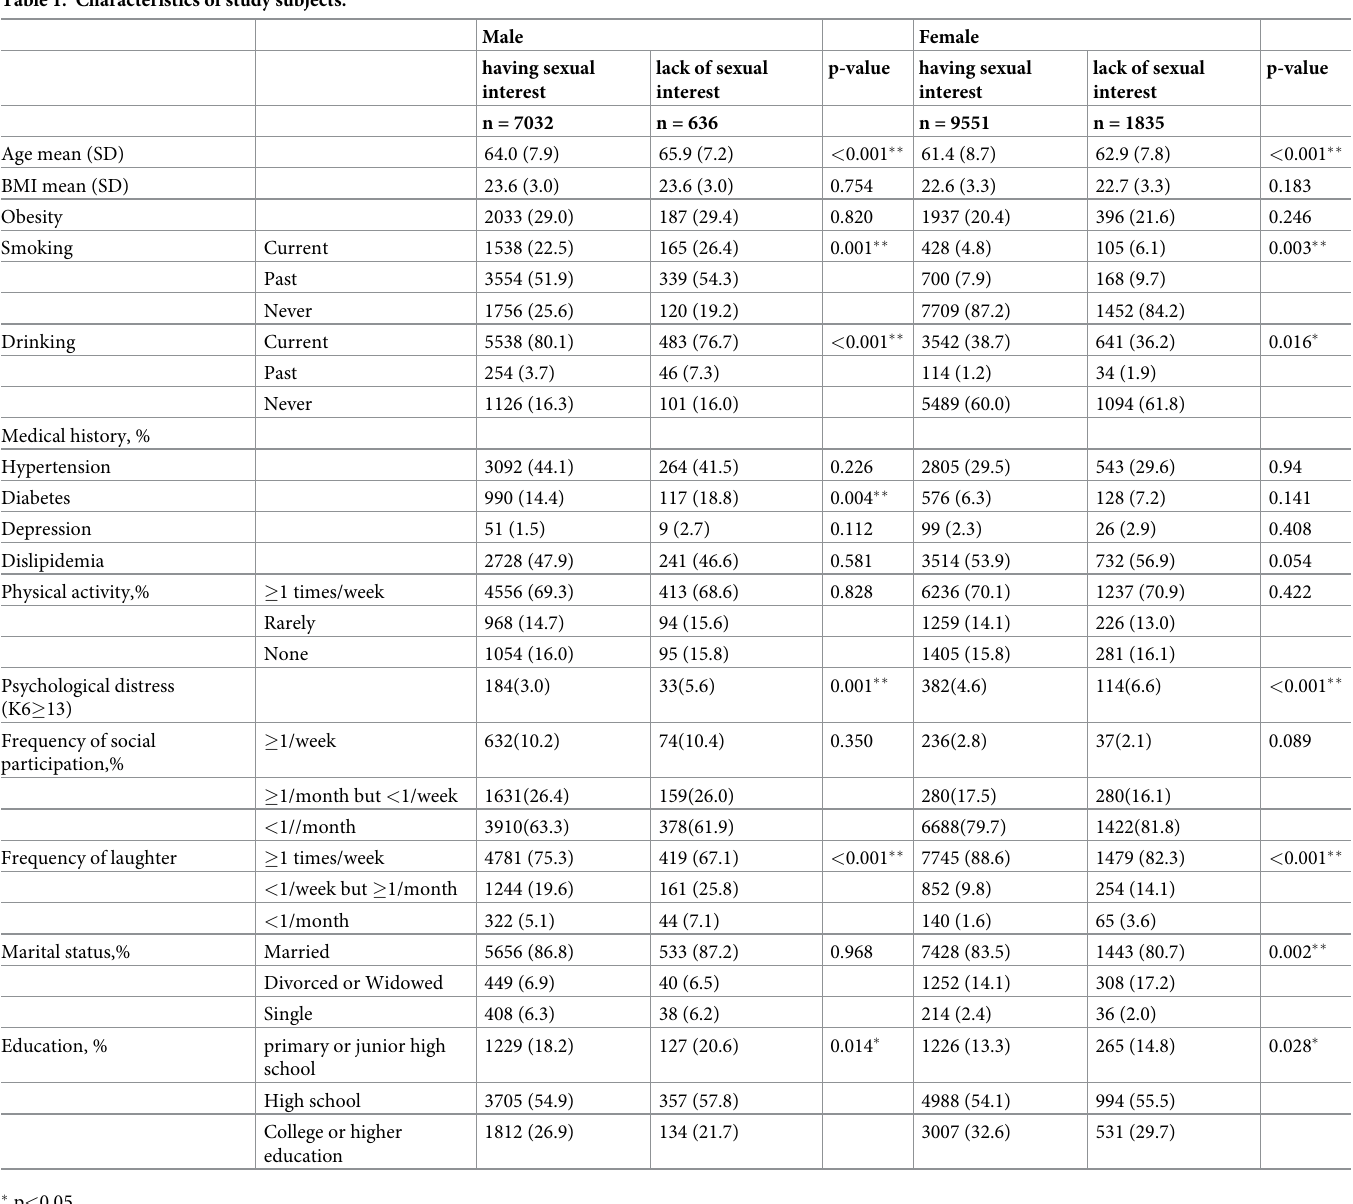
Table 1. Characteristics of study